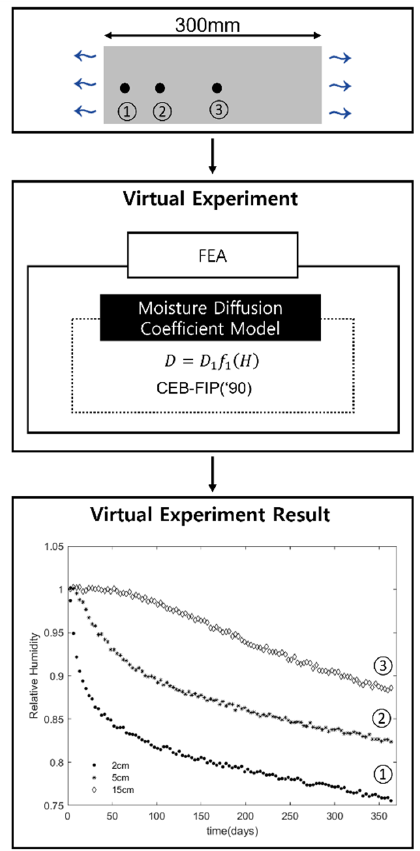
Figure 1. The schematic flow of the virtual experiment.